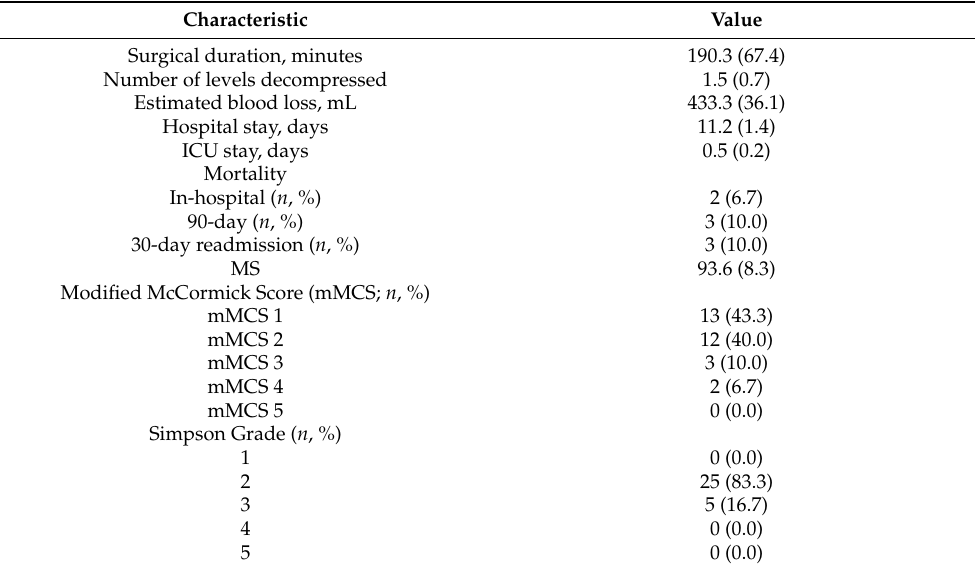
Table 2. Peri- and postoperative surgical characteristics and clinical course of the 30 patients who underwent decompression surgery.